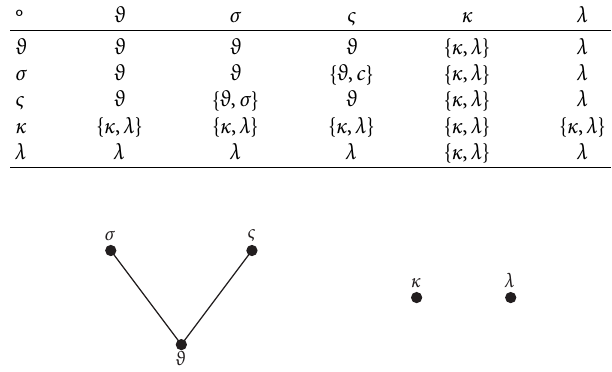
Figure 2: Figure of Θ for Example 2.